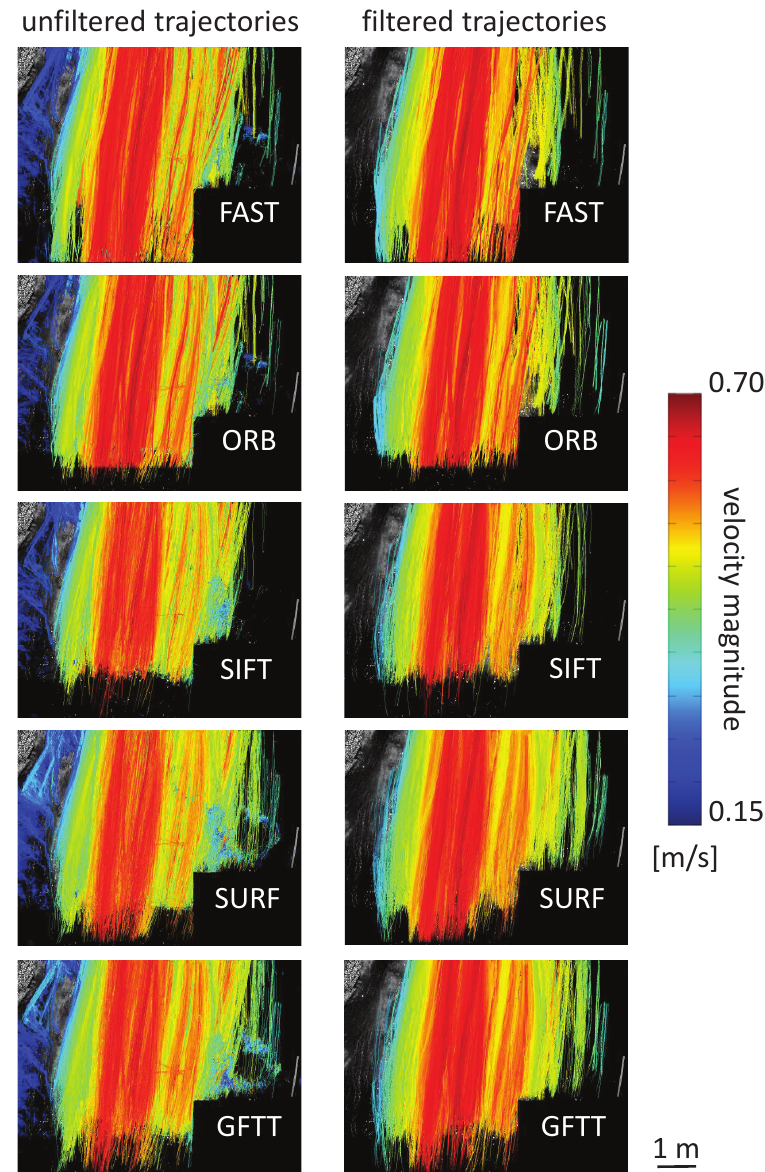
Figure 2. Unfiltered and filtered trajectories obtained with optical tracking velocimetry (OTV) and five different feature detectors for a representative video on the Brenta River. The colorbar indicates velocity magnitude for each trajectory computed as Equation (5). Flow direction is